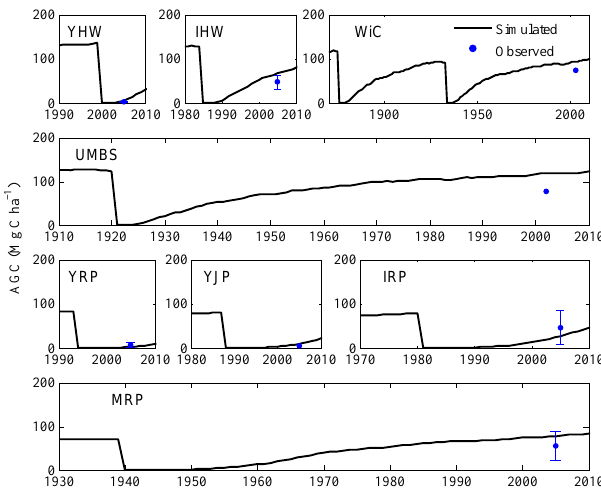
Figure 6. Simulated trajectories of LAI for each site based on the site disturbance history (Table 1). The time series started from the earliest major disturbance for each site. Symbols represent mea- sured LAI.